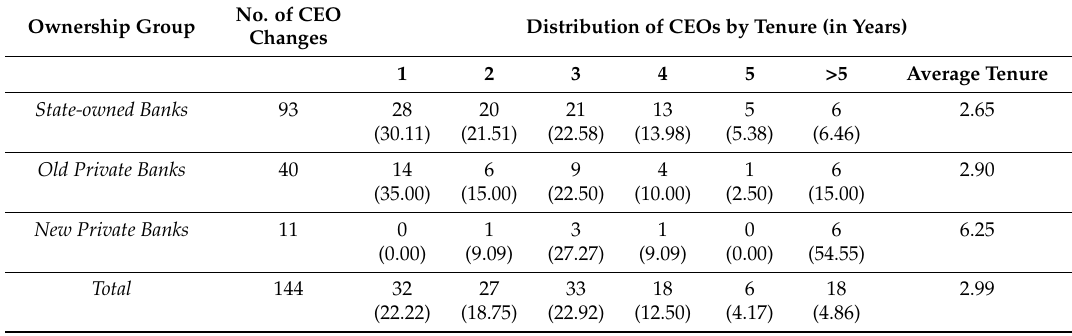
Table 7. Number of CEO Changes and Distribution of CEOs by Years of